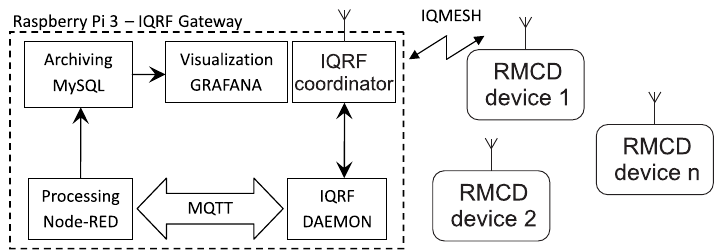
Figure 4. Scheme for processing, archiving, and visualizing measured